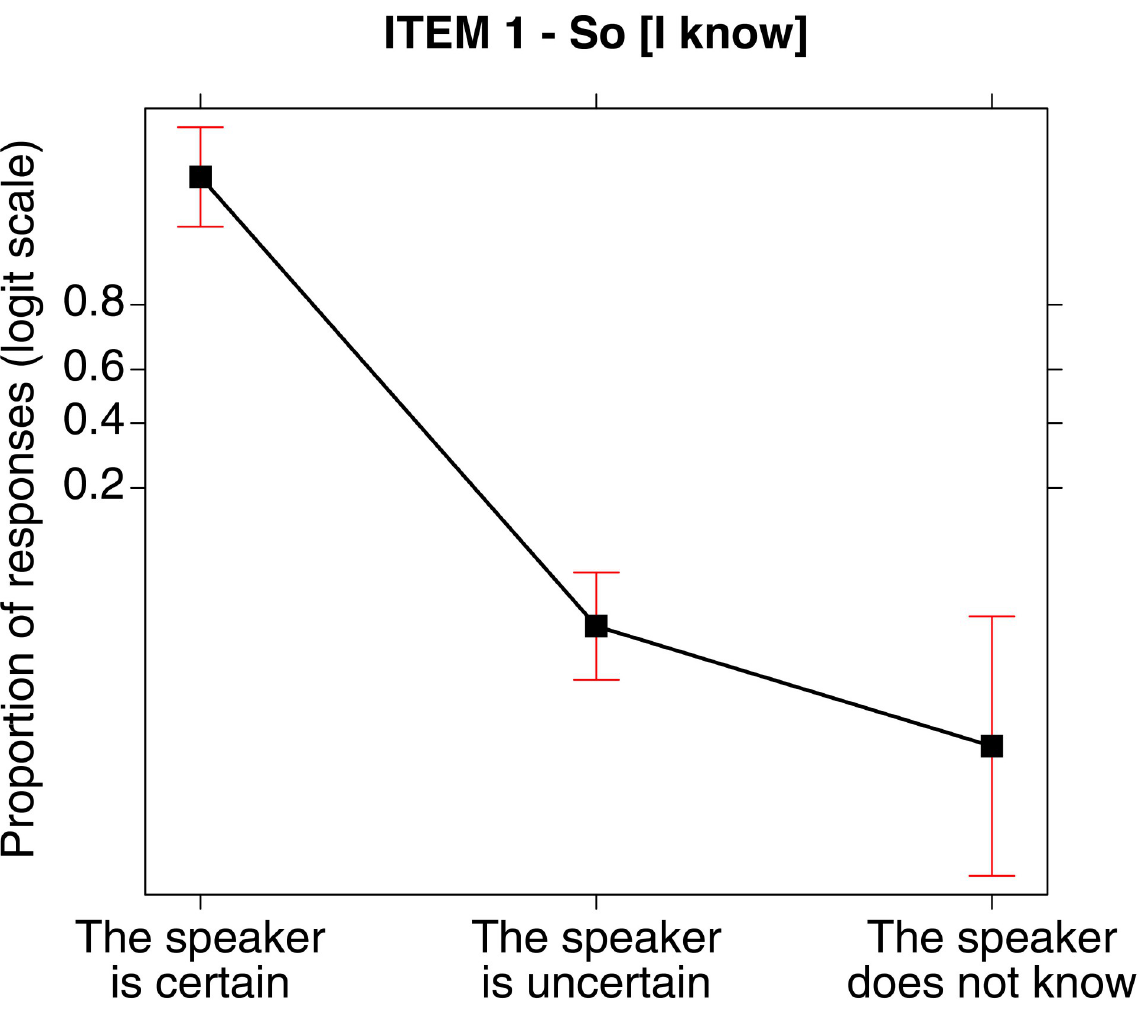
Fig 4. Sentence (1) So che p [I know that p] and the three EMPs: Probability of choosing one of them for such sentence. also that this choice significantly differs from both the unknowledge EMP (c) (post-hoc: z = 8.028, p < .001), and the uncertainty EMP (b) (post-hoc: z = 12.030, p < .001) respectively, as it is clearly visible also from the following Fig 4. Vice versa, no significant difference was found between EMPs (b) and (c) (post-hoc: z = 1.675, p = .281), which were selected by a lower number of participants. Sentence (2) Non so perché p [I do not know why p], unknowledge EMP (c). As for sen- tence (2), the analysis revealed statistically significant differences χ 2 (2, N = 201) = 223.643, p < .001 concerning the EMPs selected by the participants. In particular, the analysis pointed also that it significantly differs from the other two, i.e., both from the certainty EMP (a) (post- hoc: z = -10.999, p < .001) and the uncertainty EMP (b) (post-hoc: z = -12.765, p < .001) respectively. The analysis also revealed significant differences between the choice of the cer- tainty EMP (a) and the uncertainty EMP (b) (post-hoc: z = -3.325, p = .003), see Fig 5: Sentence (3) Non so se p [I do not know whether p], uncertainty EMP (b) and unknow- ledge EMP (c). As for sentence (3), the analysis revealed significant differences χ 2 (2,